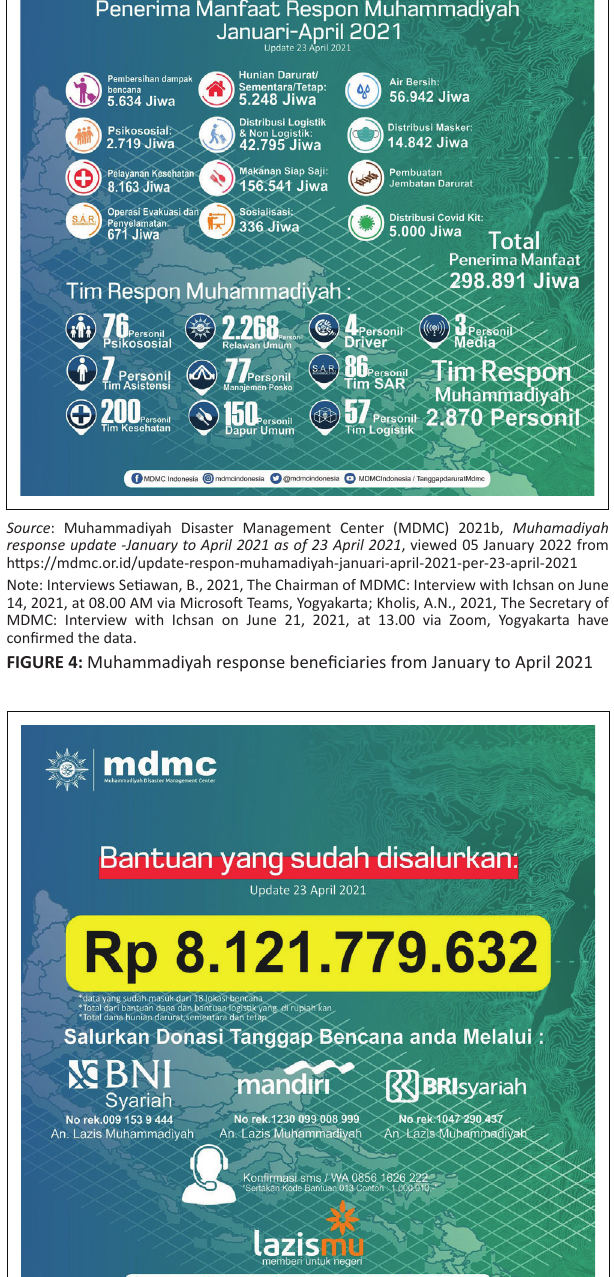
FIGURE 3: Muhammadiyah response distribution map from January to April 2021.